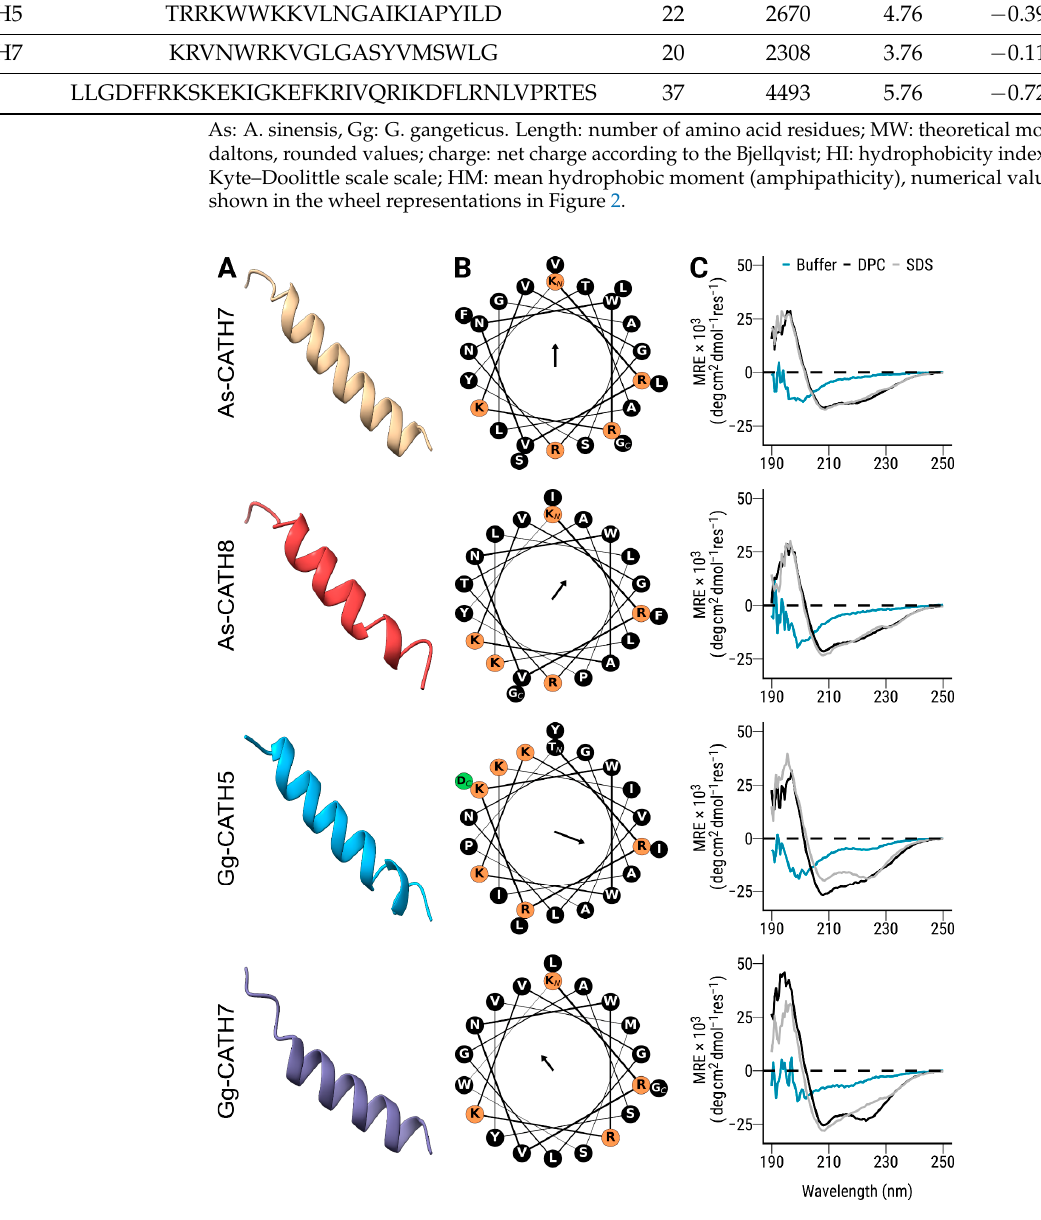
Figure 2. Structural analysis of the synthetic crocCATHs. ( A ) Three-dimensional structures were modeled using the AlphaFold algorithm and visualized in Chimera X. ( B ) Helical wheel represen- tations were generated using the Python package modlAMP. Residues with positive and negative charges are highlighted in orange and green, respectively, whereas the remaining amino acids in the sequence (largely hydrophobic) are shown in black. The orientation of the vector mean hydro- phobic moment (amphipathicity) for each sequence is displayed in the center of the wheel. The length of the arrow is proportional to the numerical values shown in Table 1. ( C ) Circular dichroism spectra of crocCATHs were obtained in sodium phosphate buffer (aqua), as well as in the presence of SDS (grey) and DPC (black) micelles. The results are shown as mean residual ellipticity (MRE).